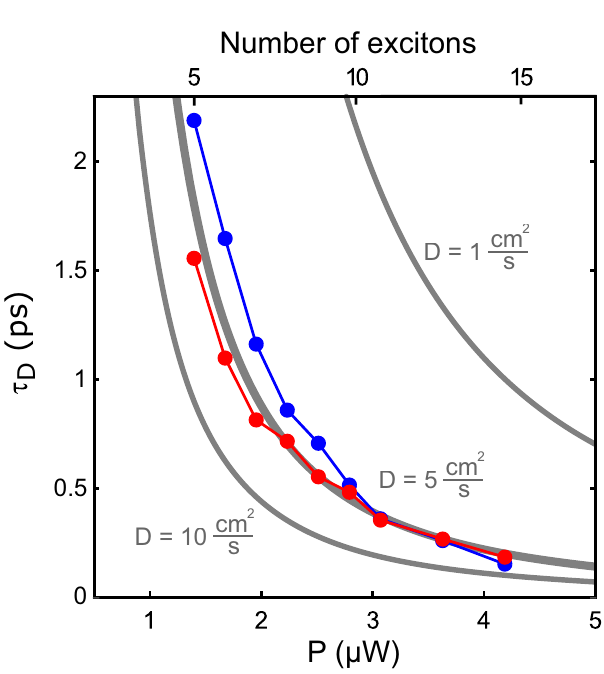
dependence of the diffusion time τ D for 4 different nanotubes derived from fi tting the detected transients. The calculated diffusional times for a diffusion coef fi cient of D =5cm 2 /s are shown as solid gray